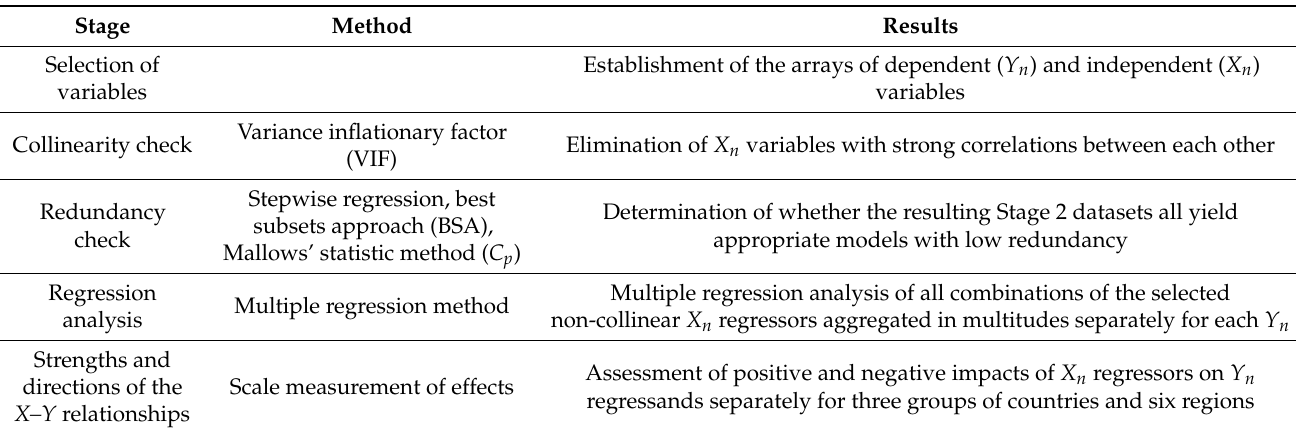
Table 1. Study algorithm: stages, methods, and